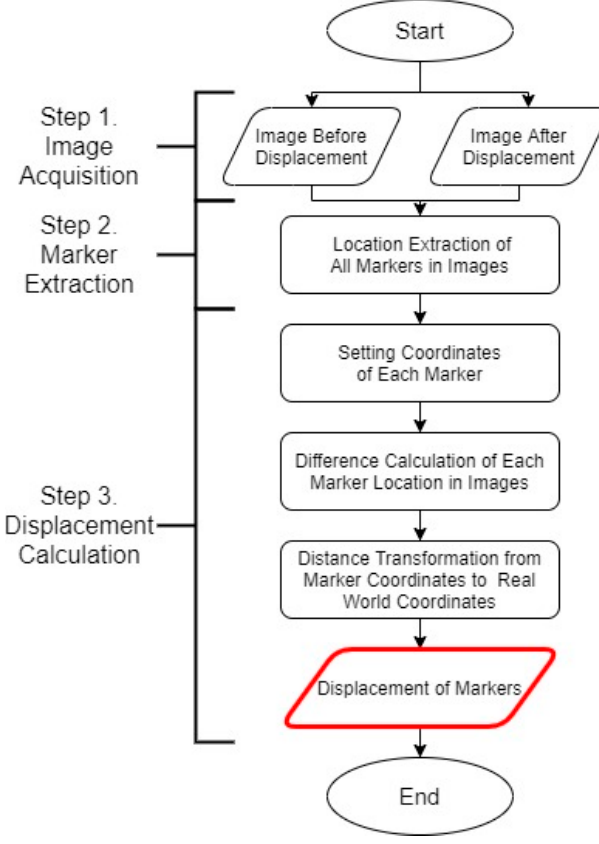
Figure 2. Conventional model of marker-based displacement measurement.